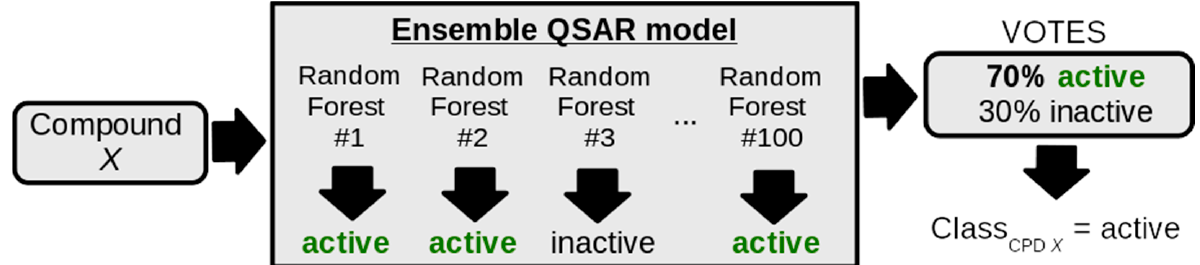
Figure 3. Example of how a prediction for each compound is obtained. Whenever a model was trained, the number of Random Forests in the ensemble was optimized.